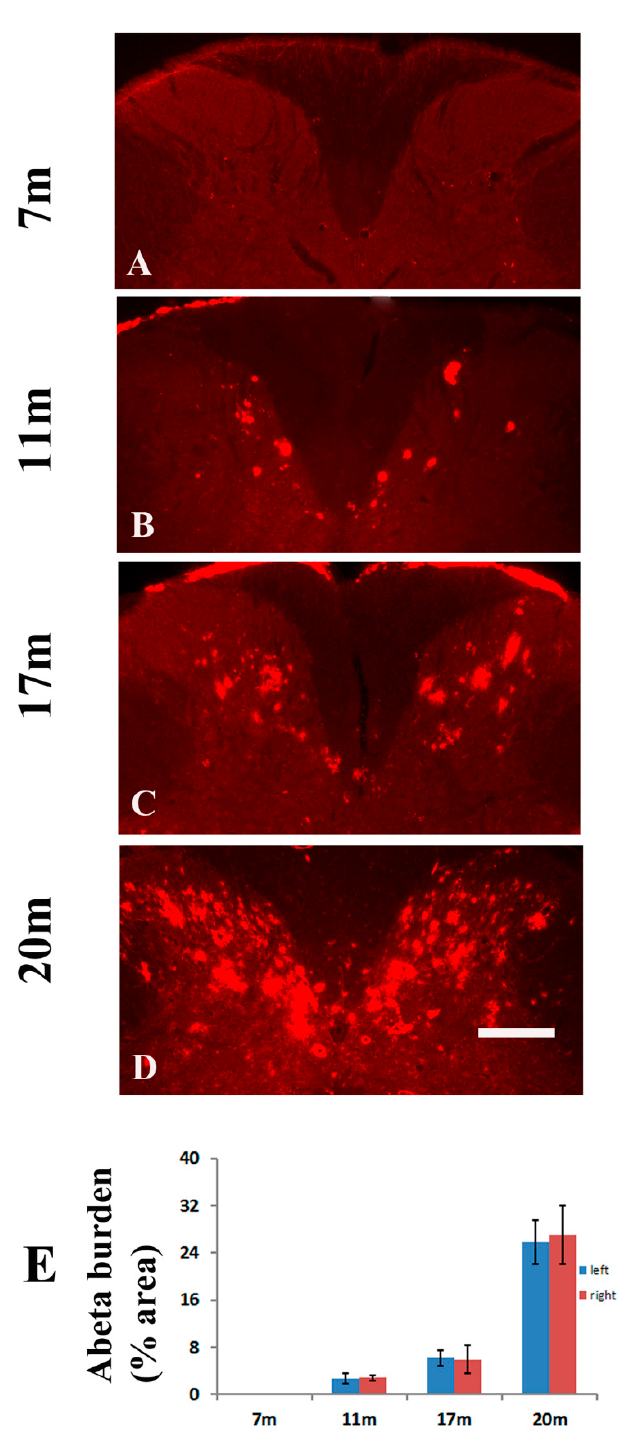
Figure 1. Age-dependent accumulation of A β plaques in the dorsal horn of the spinal cord of TgCRND8 mice. Representative photomicrographs of progressive A β pathology in cross sections of the cervical cord of TgCRND8 mice at 7, 11, 17, and 20 months of age. A β immunofluorescence study revealed an absence of A β pathology in the spinal cord at the age of 7 months ( A ). A few A β plaques could be observed in the dorsal horn at the age of 11 months ( B ) and increased with aging ( C , D , respectively). ( E ) Quantitative analysis of amyloid burden in the dorsal horn of the spinal cord of TgCRND8 mice. For each individual animal analyzed, amyloid burden in the left was compared with the burden in the right side in the dorsal horn. No difference in amyloid burden could be observed. Scale bar, 150 μ m.